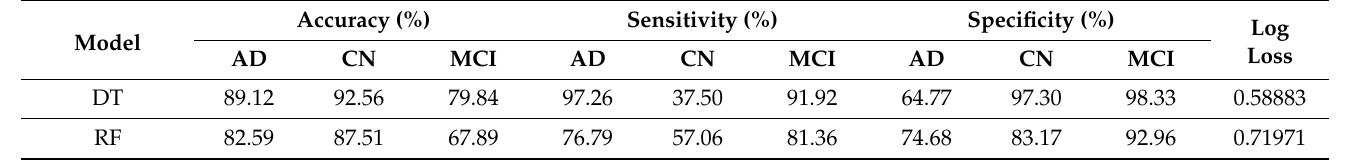
Table 6. After hyperparameter tuning (parameter optimization) using